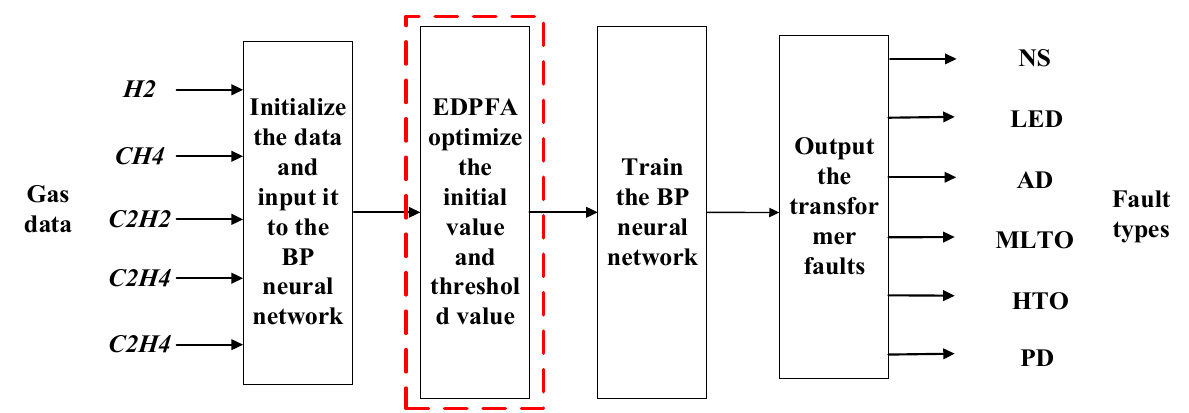
Figure 6. The transformer fault diagnosis model based on the EDPFA ‐ BP neural network.